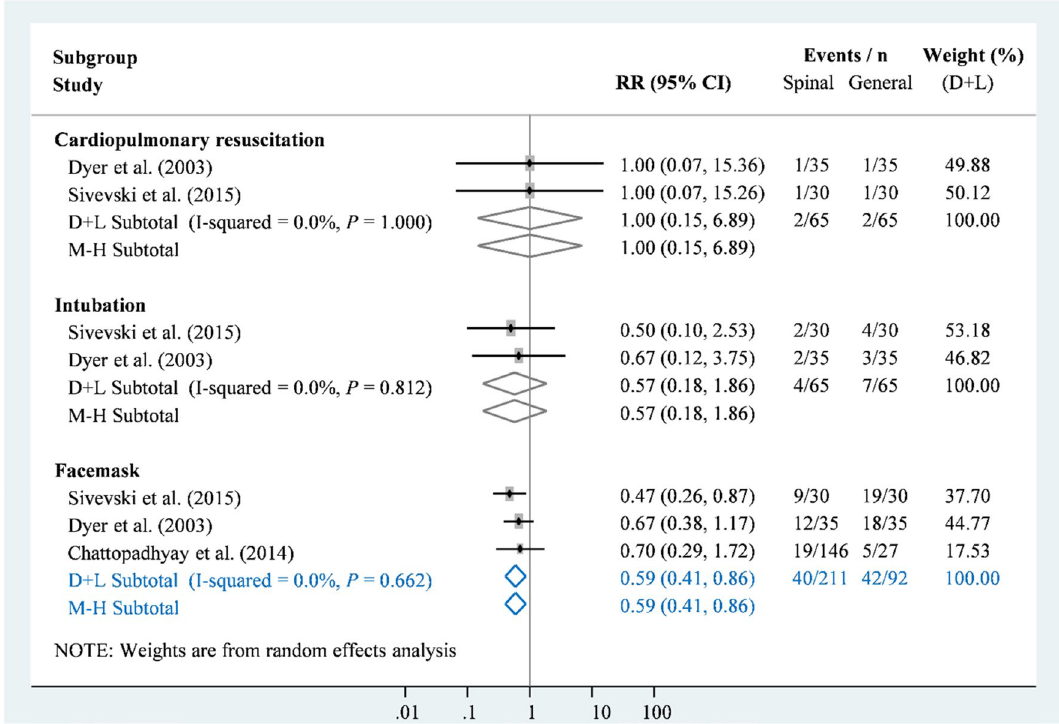
Figure 4. Forest plot of anaesthesia strategies for neonatal